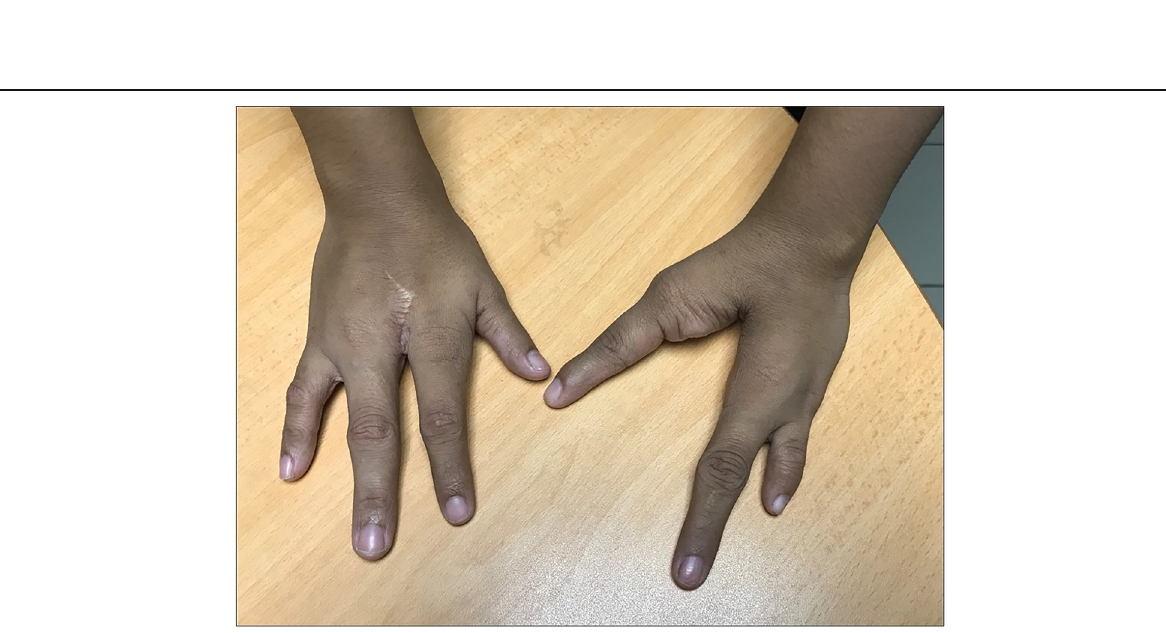
Fig. 3 Clinical photographs of the hands of the mother showing bilateral ectrodactyly involving both hands, with the absence of the third digit on the right hand and two digits on the left hand, with bi-phalangeal left 5th